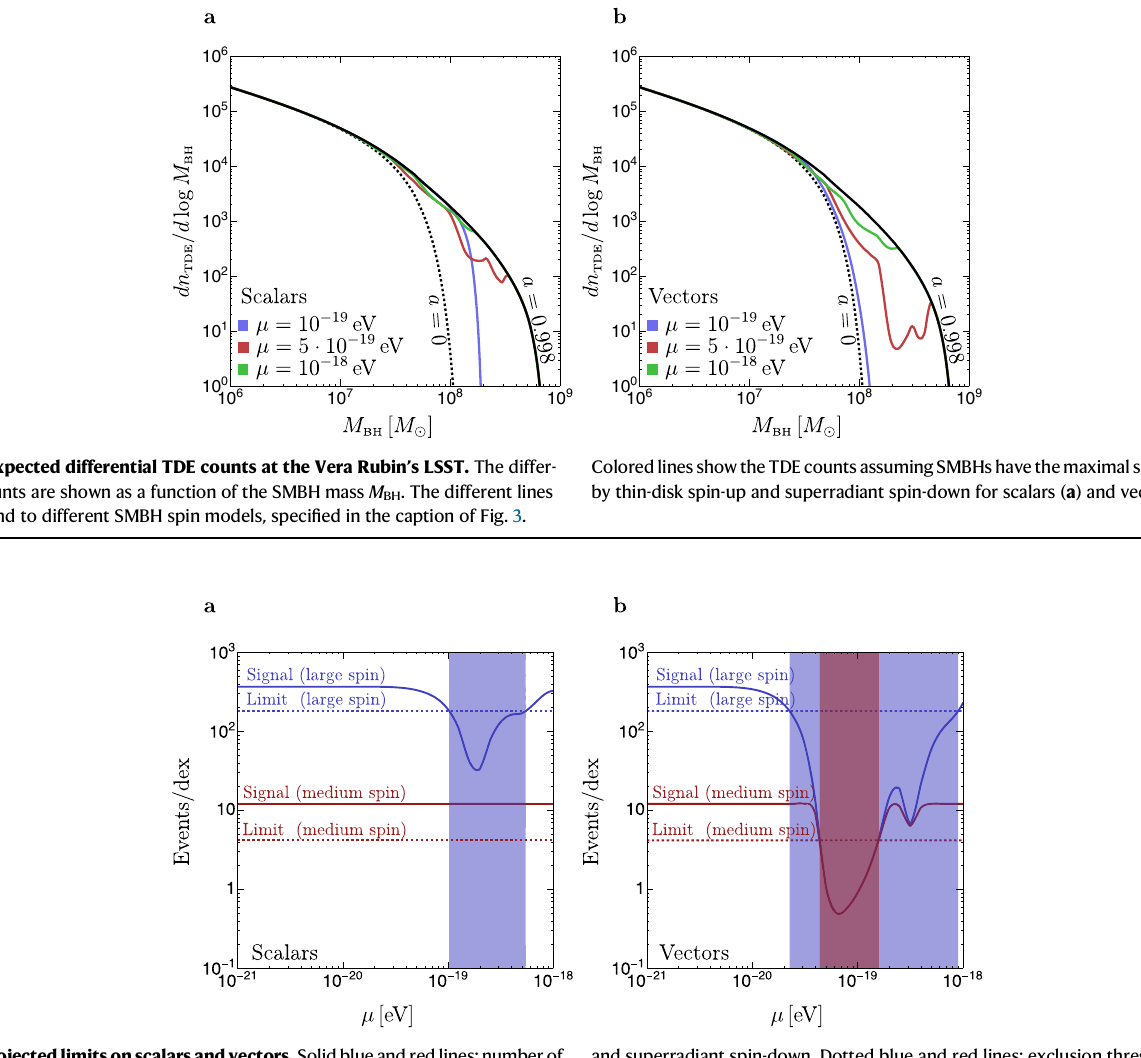
and superradiant spin-down. Dotted blue and red lines: exclusion thresholds assuming that LSST TDE rate measurements are consistent with SMBHs having “ large'' ( a =0.998) or “ medium'' ( a =0.6) spins. These thresholds are obtained by calculating the number of TDEs that LSST would observe in the mass bin 8 ≤ log M BH = M (cid:1) ≤ 9 in the absenceof superradiant effects, and accounting for a2 σ statistical and a 50% systematic uncertainty (downward fl uctuation) on the mea- surement.Blueandredregions:projectedlimitsonthemassesofULBsforthetwo spin assumptions.